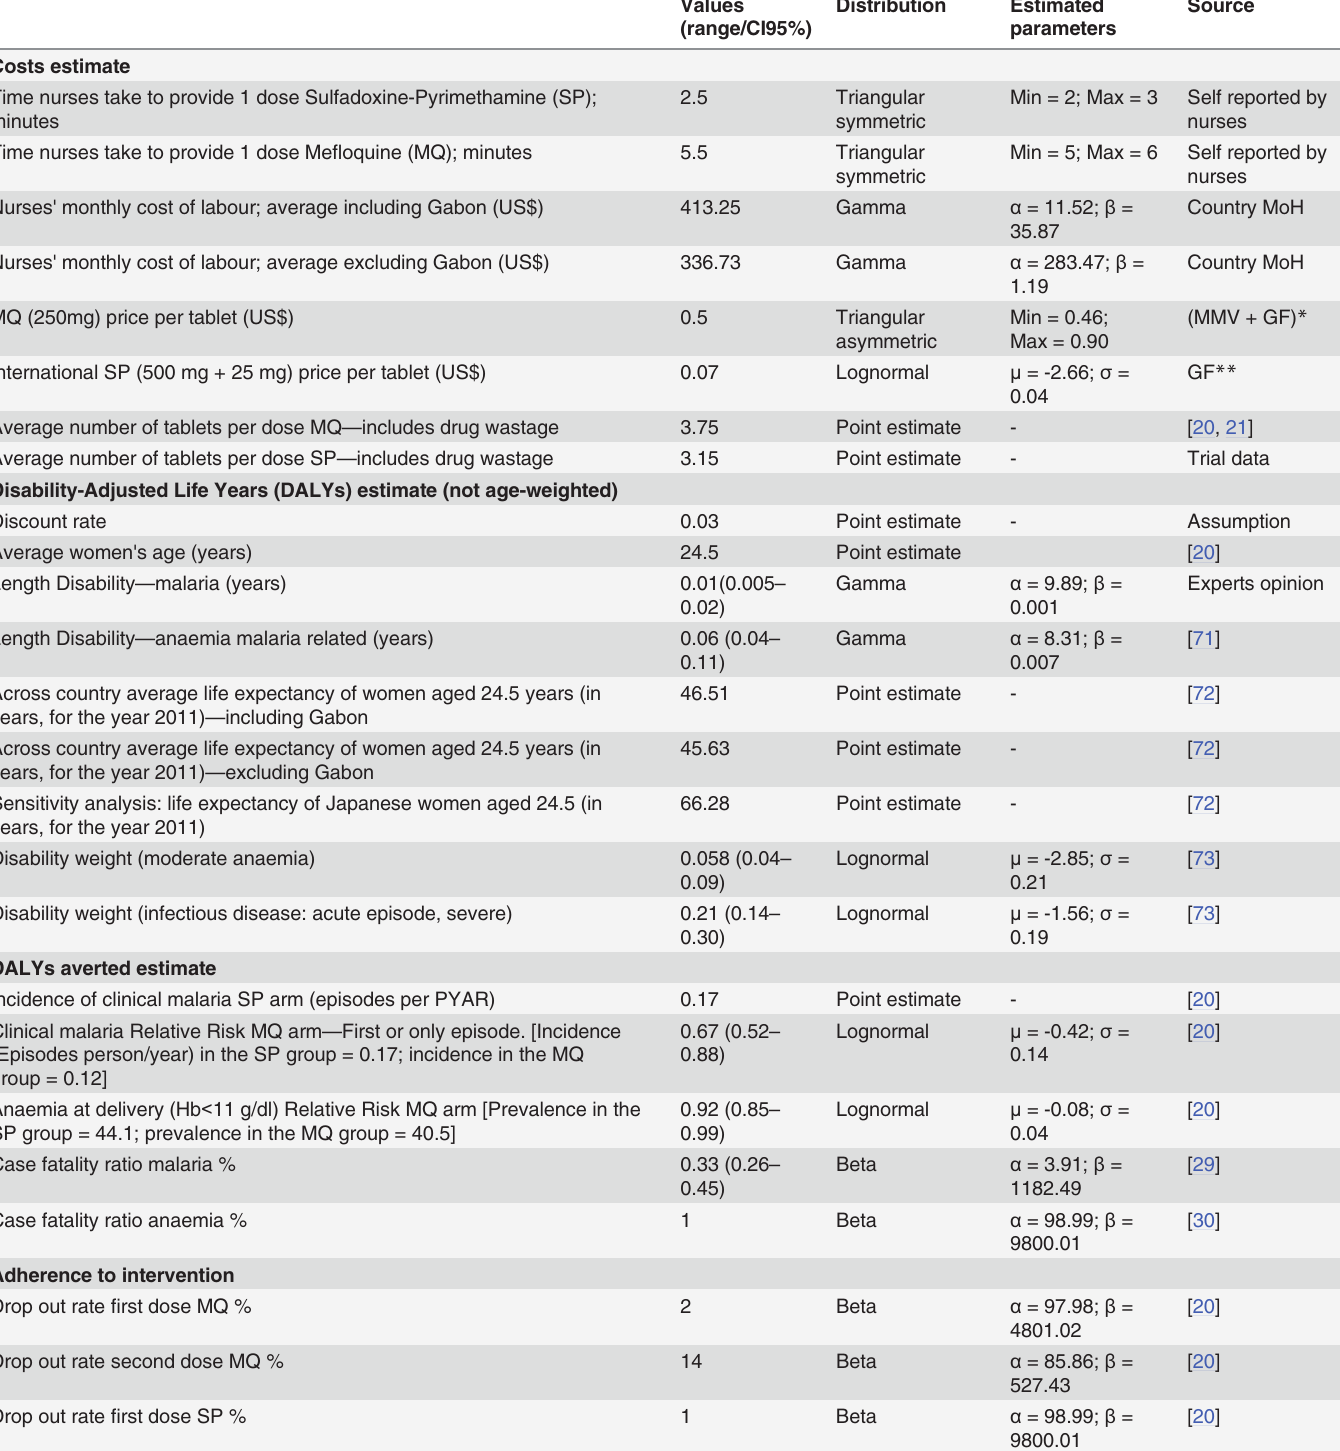
Table 1. Input variables of the threshold and cost-effectiveness analyses of IPTp-MQ compared with IPTp-SP in HIV-negative pregnant